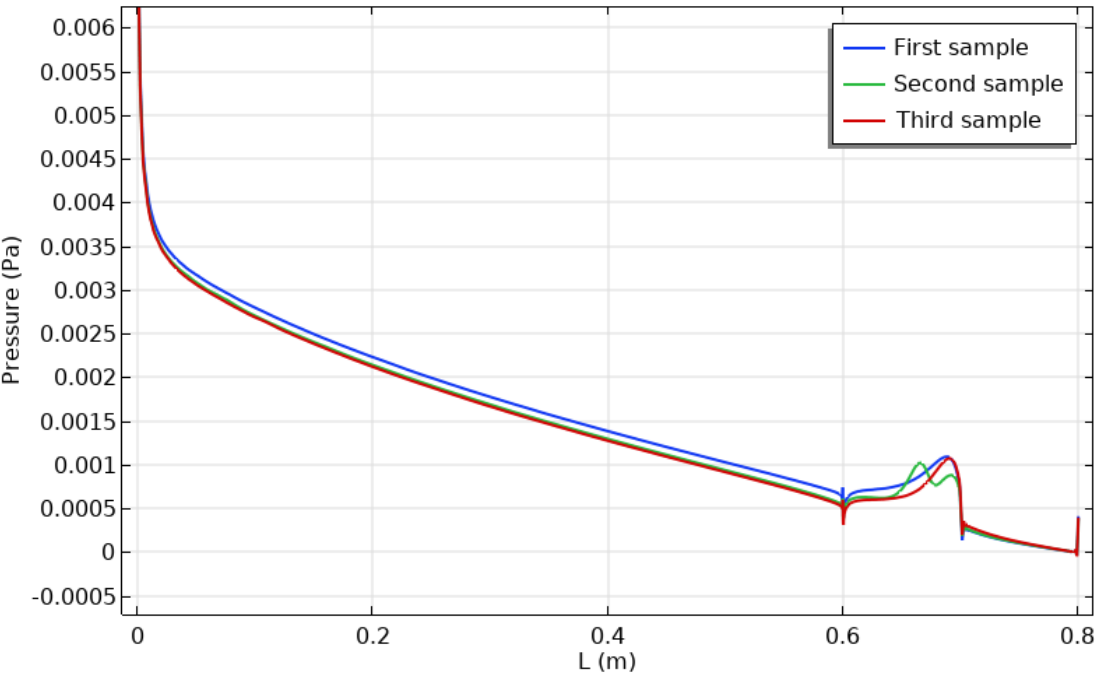
Figure 15 . Local pressure in the channel–enclosure assembly .